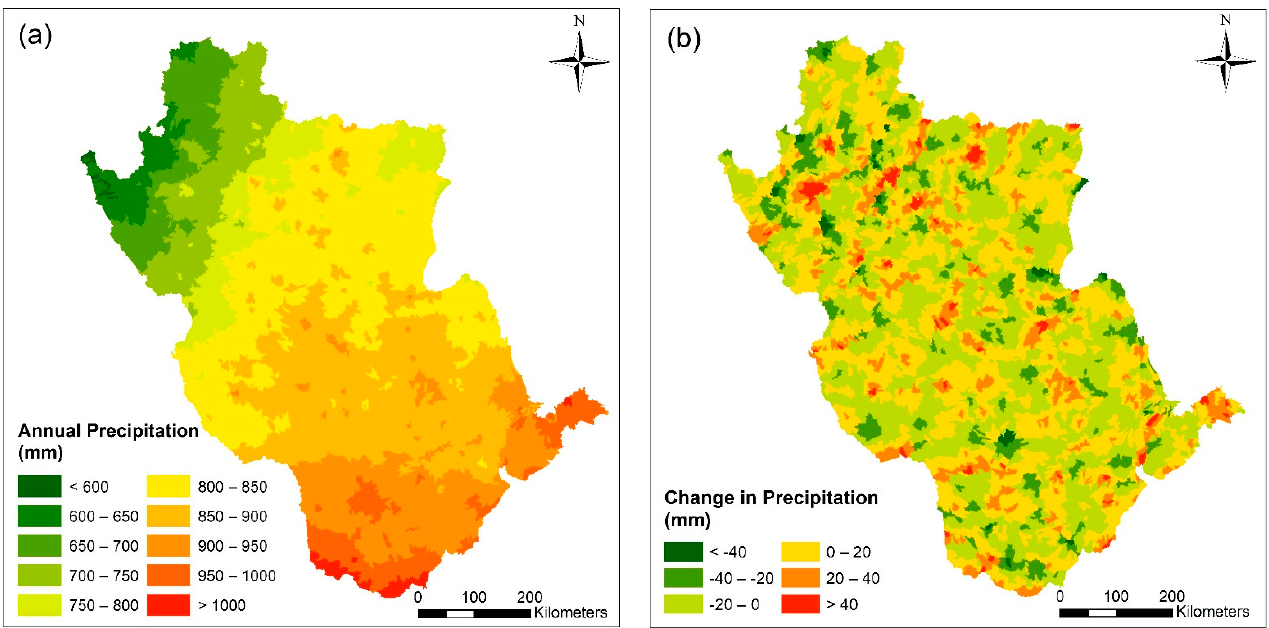
Figure 7. Average annual precipitation in HUC12 delineation scenarios for ( a ) the Parameter-elevation Relationships on Independent Slopes Model (PRISM) dataset and ( b ) absolute changes from PRISM to PRISM* from 1983 to 2005.